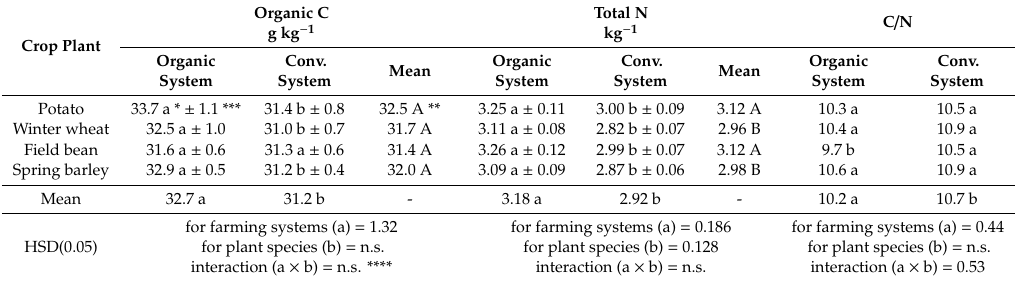
Table 13. Organic carbon and total nitrogen content and C / N ratio in the 0–25 cm soil layer.